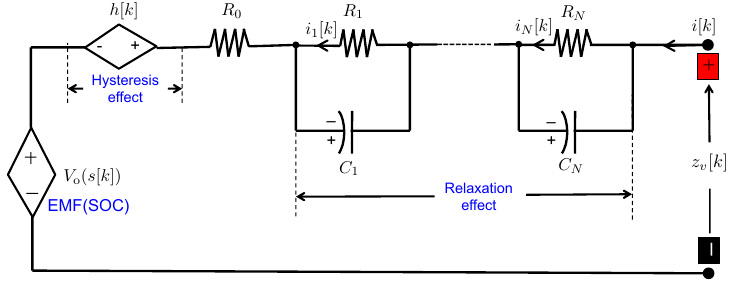
Figure 7. Equivalent circuit model of a battery. Identifying the battery model and estimating its parameters are crucial steps for all aspects of a battery management system, from state of charge estimation to optimal charging to charge and thermal balancing. In practice, reduced models, shown in Figure 8, are employed; In Reference [69] a unified approach to ECM model parameter estimation is